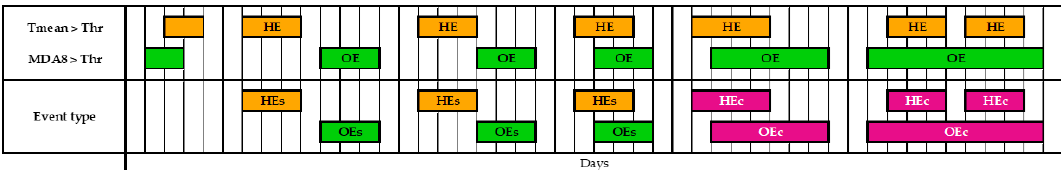
Figure 2. Schematic overview of possible threshold (Thr) exceedances (top row). The resulting heat events (HE) and ozone events (OE) are labeled. The classified event types that were used in the analyses were defined as single heat events (HEs), single ozone events (OEs), coupled heat events (HEc), and coupled ozone events (OEc).